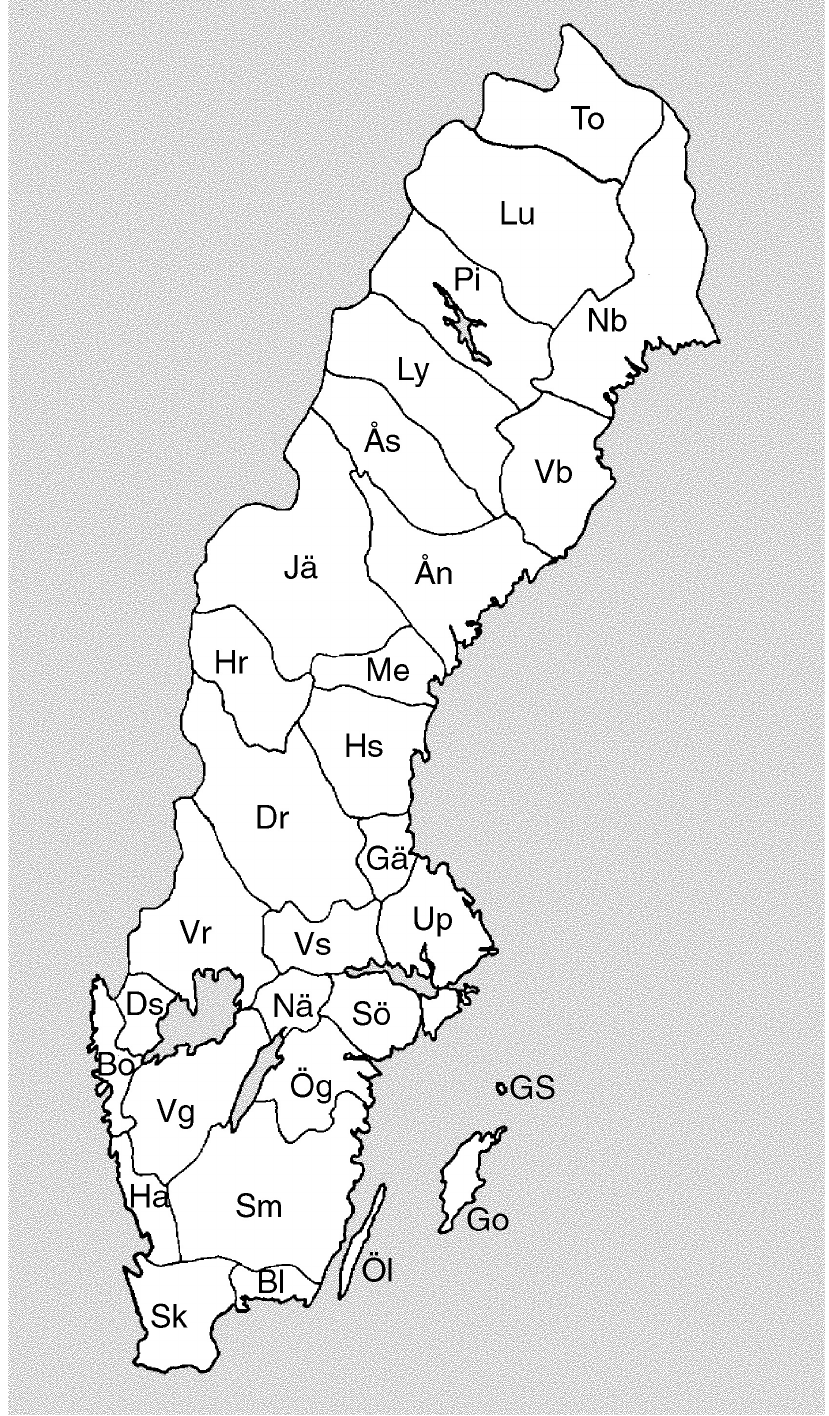
Fig. 2. Map of Sweden with borders and used abbreviations of the faunistic provinces from south to north: Sk = Skåne, Bl = Blekinge, Ha = Halland, Sm = Småland, Öl = Öland, Go = Gotland, Ög = Östergötland, Vg = Västergötland, Bo = Bohuslän, Ds = Dalsland, Nä = Närke, Sö = Södermanland, Up = Uppland, Vs = Västmanland, Vr = Värmland, Dr = Dalarna, Gä = Gästrikland, Hs = Hälsingland, Me = Medelpad, Hr = Härjedalen, Jä = Jämtland, Ån = Ångermanland, Vb = Västerbotten, Nb = Norrbotten, Ås = Åsele lappmark, Ly = Lycksele lappmark, Pi = Pite lappmark, Lu = Lule lappmark, To = Torne